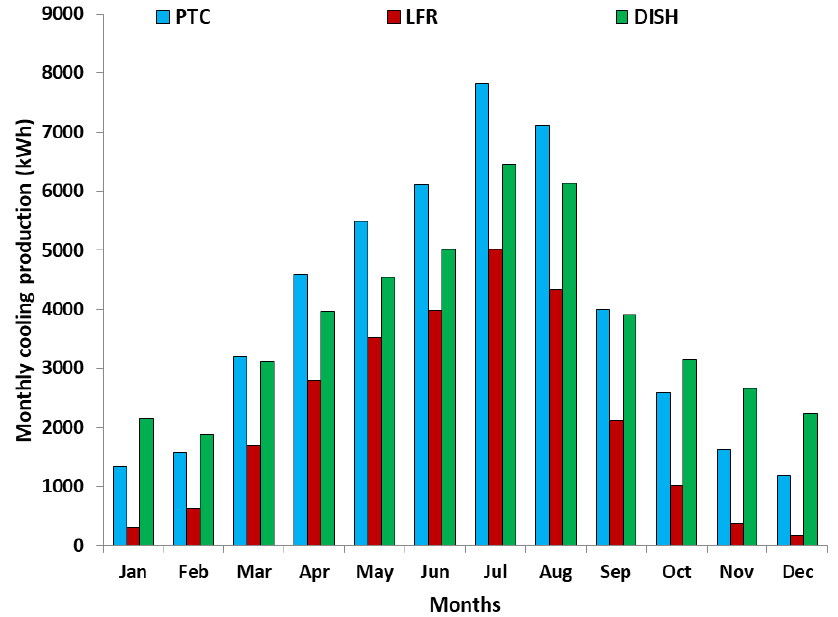
Figure 11. Monthly cooling production for the three solar collectors.